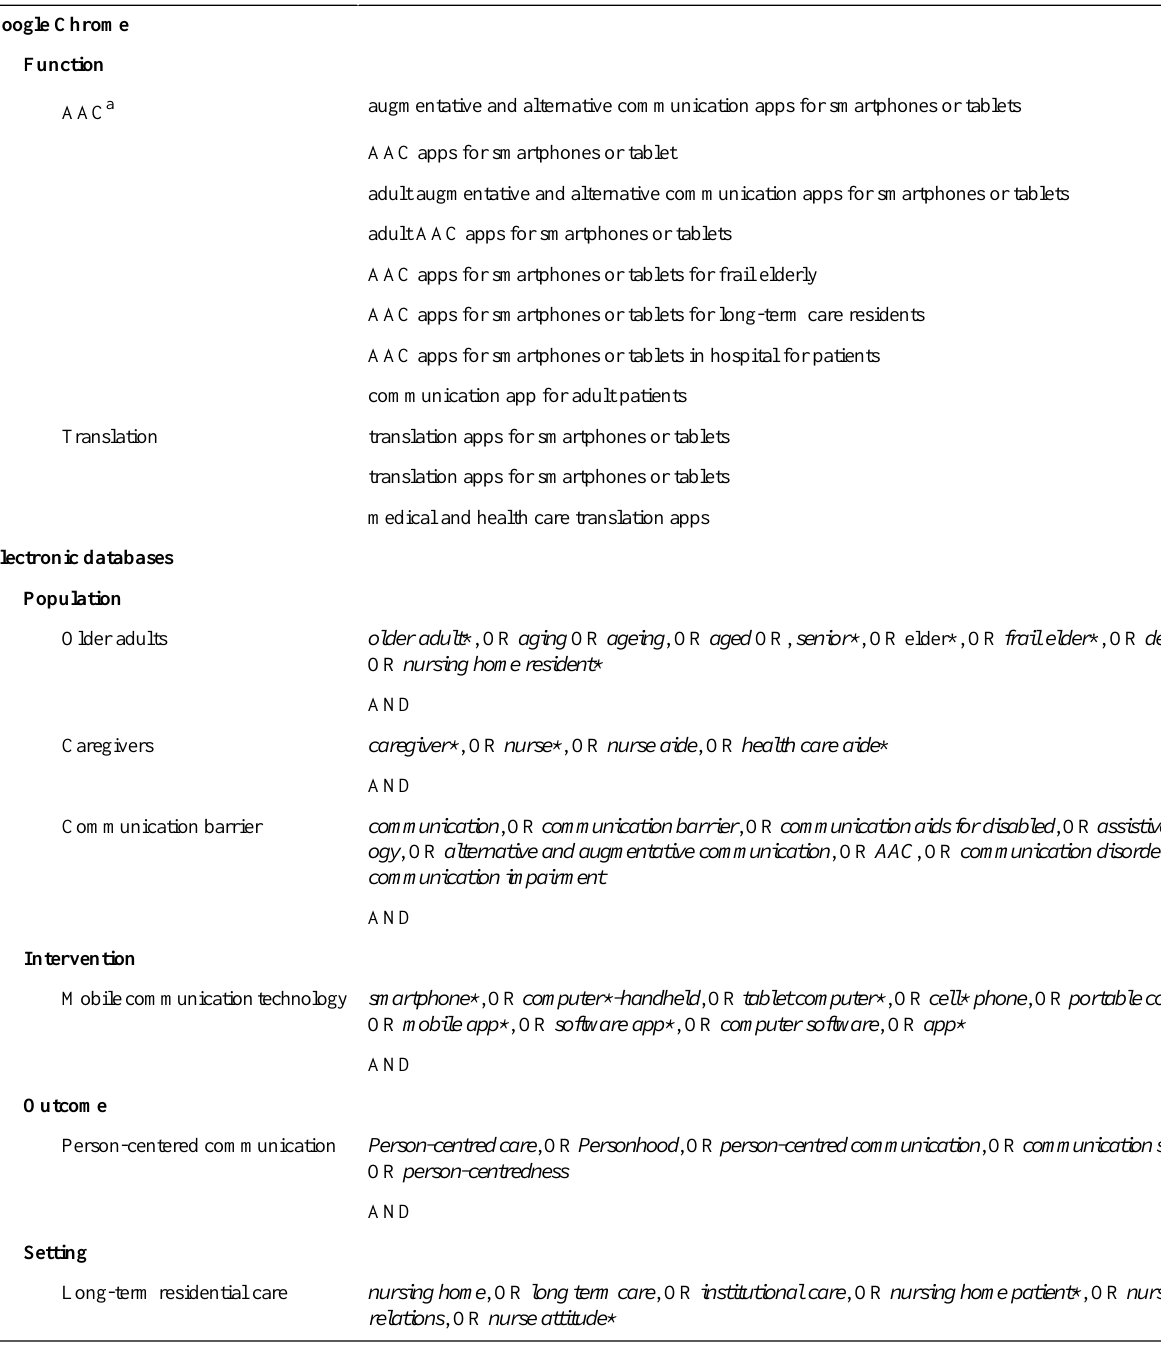
Table 1. Search terms used in Google Chrome and electronic databases. Google